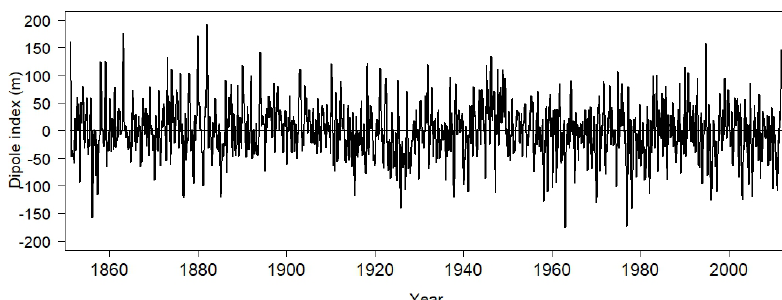
Figure 6. The 3-month running mean of the dipole index.